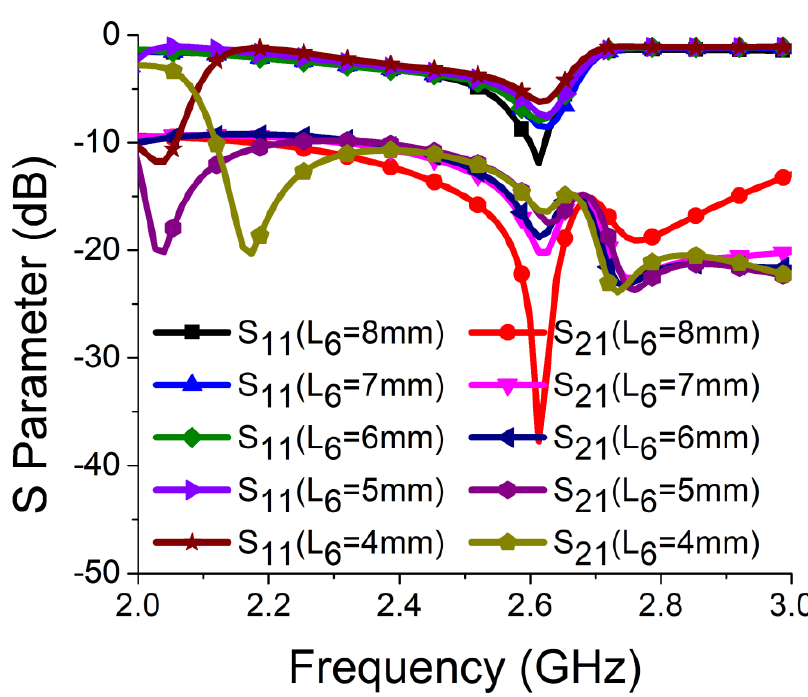
Figure 5. MIMO antenna with SRR-based BSF: ( a ) group delay and phase response; ( b ) current distribution; ( c ) S parame- ters.